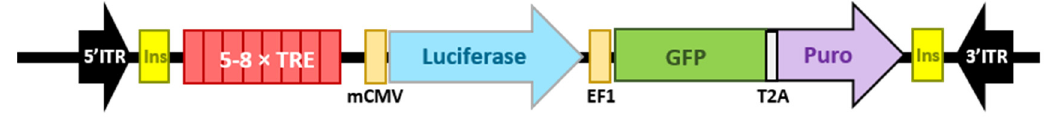
Figure 5. The construct for a transcriptional activity reporter. Abbreviations: TRE, transcriptional response elements; mCMV, minimal CMV promoter; EF1, elongation factor 1 α promoter; GFP,